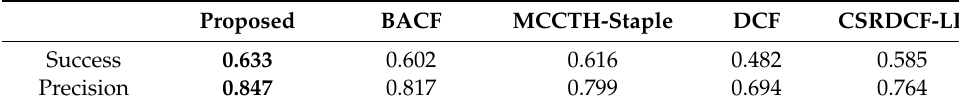
Figure 14. Evaluation Graph of OTB-100 for All Attributes ( a ) Success Plots Graph of OTB-100, ( b ) Precision Plots Graph of OTB-100.